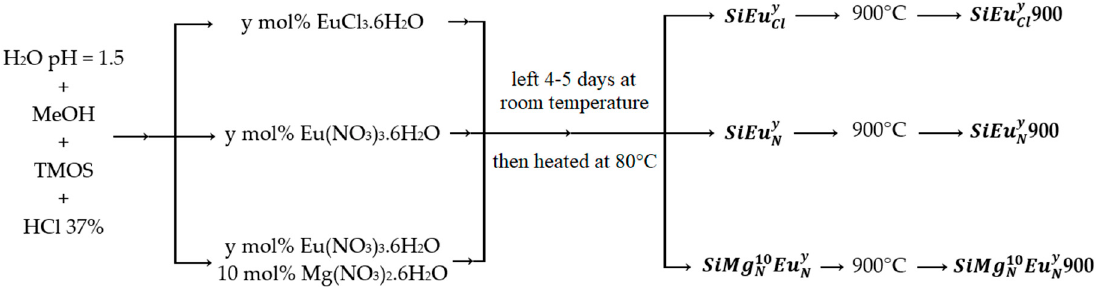
Figure 6. The main preparation route of the different glasses. The bolded names correspond to the nomenclature of the samples.